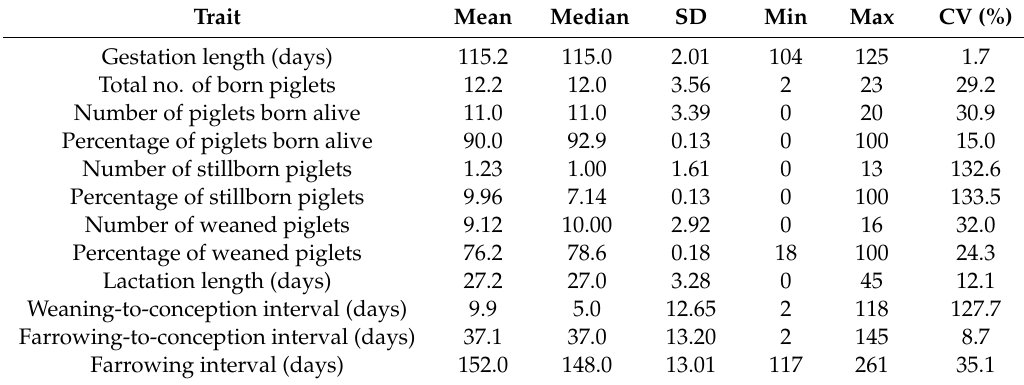
Table 2. Summary statistics for the analyzed reproductive traits of sows (across the breeds studied).